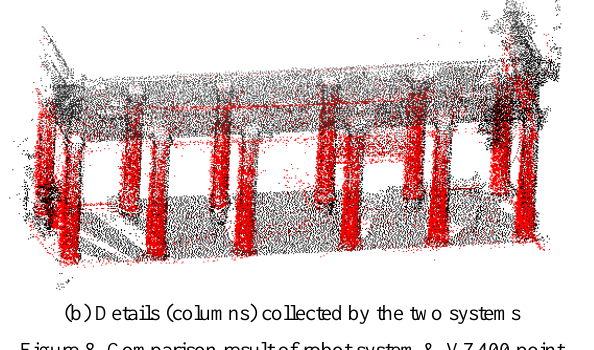
Figure 8. Comparison result of robot system & VZ400 point clouds in the outdoor scene (red represents point clouds collected by robot system, black represents point clouds collected by